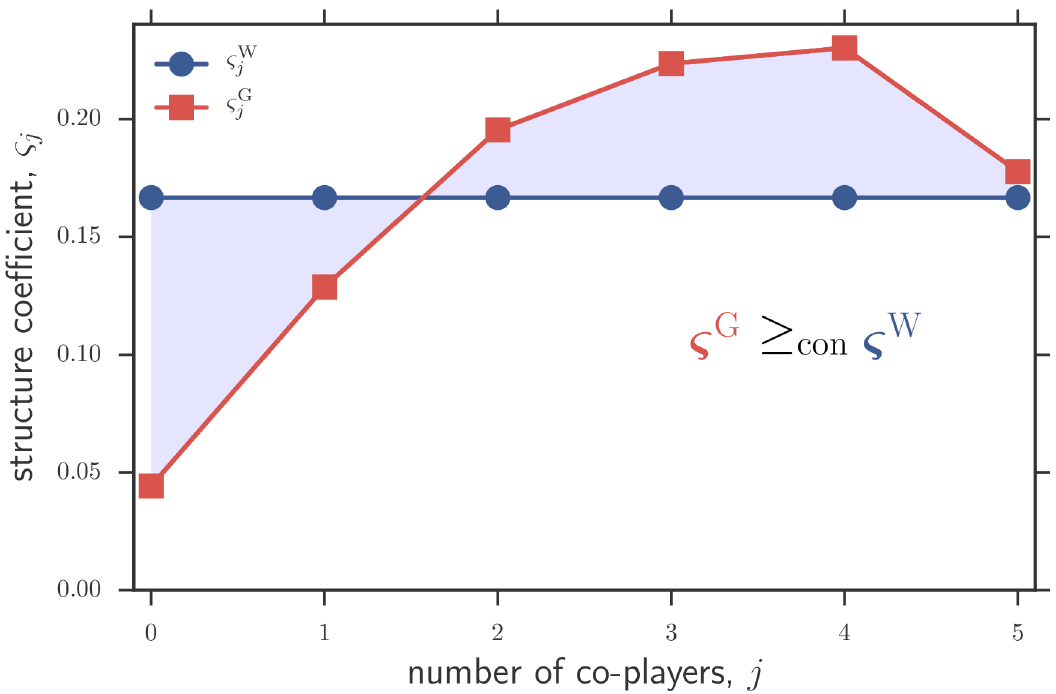
Fig 2. Structure coefficients and containment order of cooperation. Approximated (normalized) structure coefficients ς j for large regular graphs of degree k = 5 updated with a Moran death-Birth process ( B G j ) and large well-mixed populations where groups of d = 6 players are randomly matched to play a game ( B W j ). Since ς G − ς W has one sign crossing from − to +, the graph is greater in the containment order than the well-mixed population (denoted by B G (cid:7) con B W ). Consequently, if the sigma rule holds for a well-mixed population with coef fi cients ς W , then it also holds for a graph-structured population with coef fi cients ς G , for any cooperation